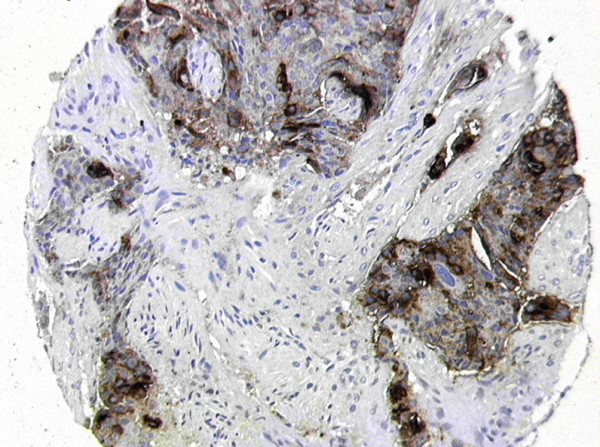
Tissue microarray core demonstrating tumour with moderate Lewisy/b expression. Thirteen percent of tumours showed moderate expression of Lewisy/b.